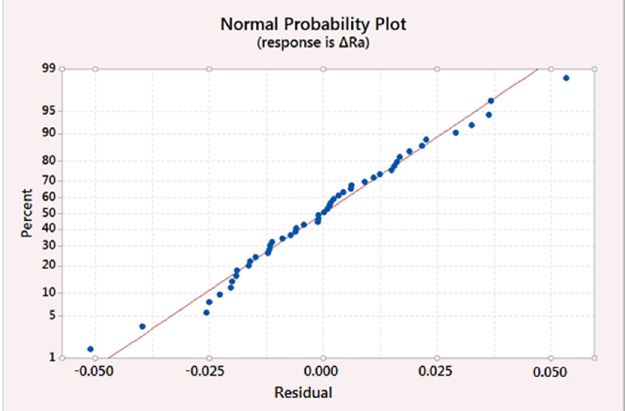
Fig. 8. The effect of the machining time on D R a (1 =30 min, 2= 60min).